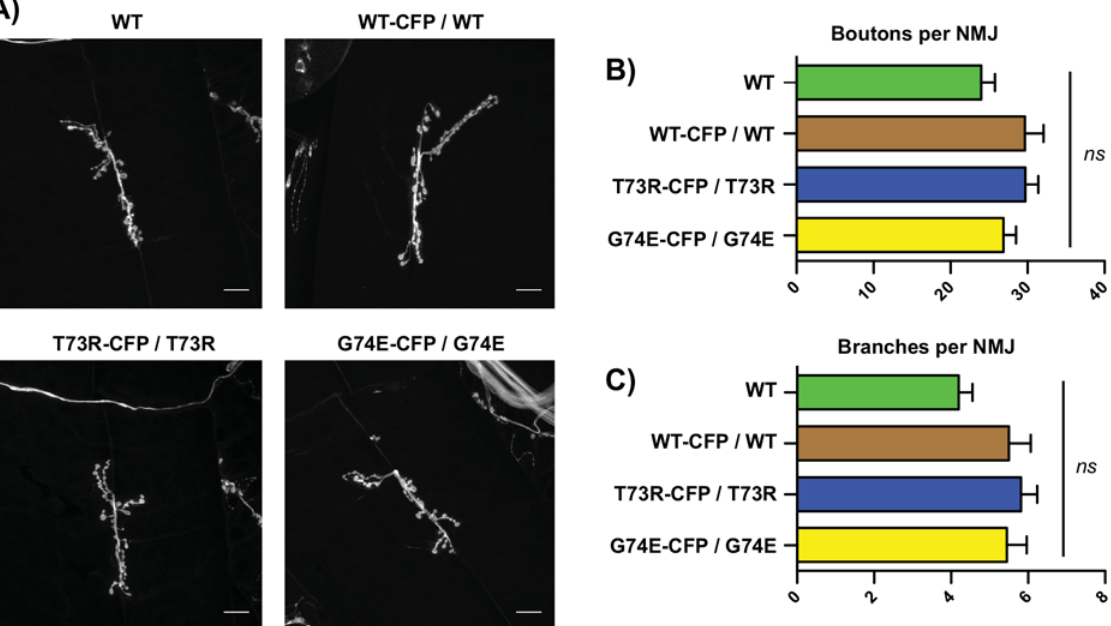
Fig 8. TPI dimer interface substitutions do not alter NMJ development and morphology. (A) NMJ morphology of segment A2 muscle 6/7 was characterized for (B) bouton number and (C) branching. Boutons were defined as varicosities greater than 2 μ m in diameter. Neither parameter showed significant differences elicited by the mutations, relative to either dTPI WT or dTPI WT-CFP /TPI WT . CFP tags did not alter the behavioral deficits of the animals (S6 Fig). n = 10. Comparisons were made with a One-way ANOVA using Tukey ’ s post hoc test, ns indicated no significance. Scale bar = 10 μ m.